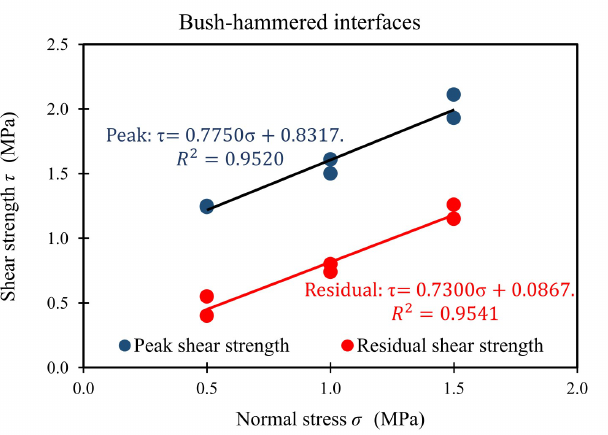
Figure 10. Peak and residual shear strength in terms of normal stress (bush-hammered